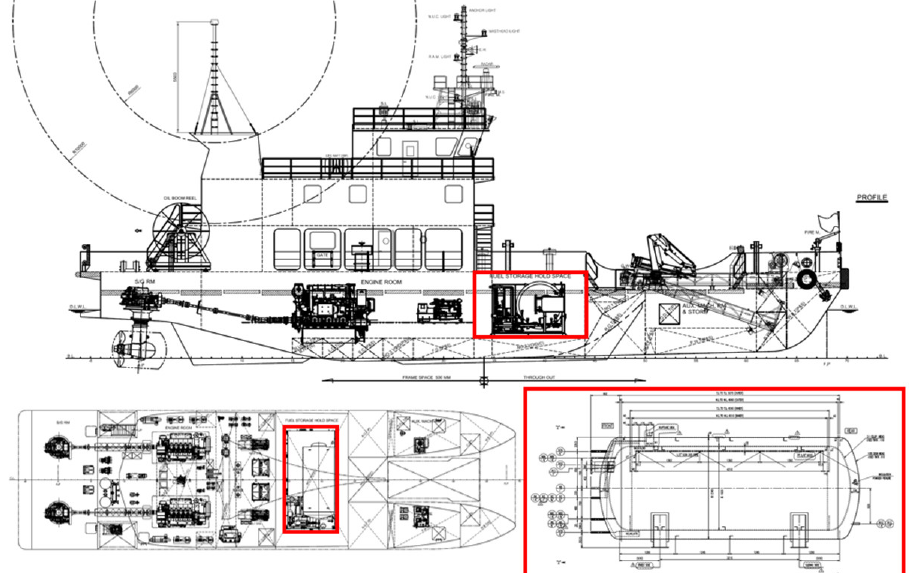
Figure 2. General configuration of target ship and location of LNG fuel tank. Table 1. Specifications of target vessel with type-C cylindrical tank.